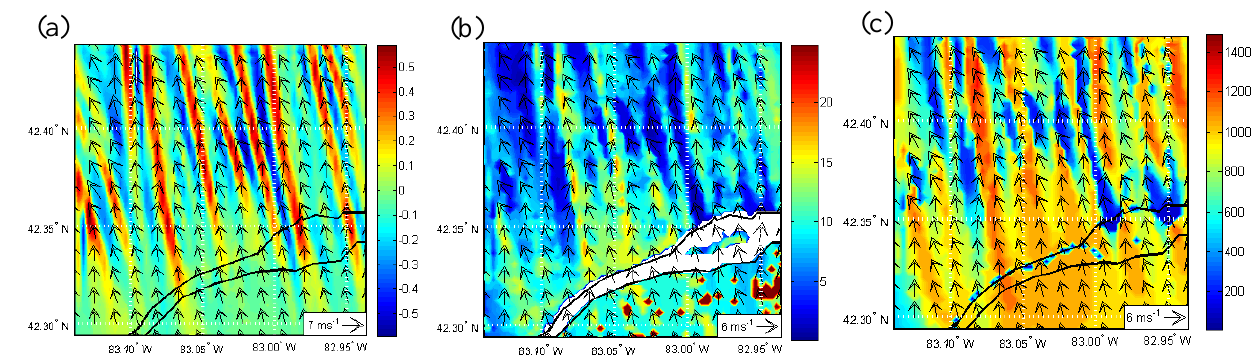
Fig. 8. Vertical velocity (ms − 1 ) at the midpoint of the second lowest layer above the surface ( ∼ 91ma.g.l.) (a) , a non-dimensional Obukhov stability parameter ( − zi/L ) (b) and ABL depth (m) (c) , all evaluated over the 4th model grid in case 10s at 18:20UTC 24 June 2007. All figures show horizontal wind at the midpoint of the lowest model layer (except (a) ) in black vectors, scaled by the reference vector at the lower right, each vector being separated by approximately four grid cells.